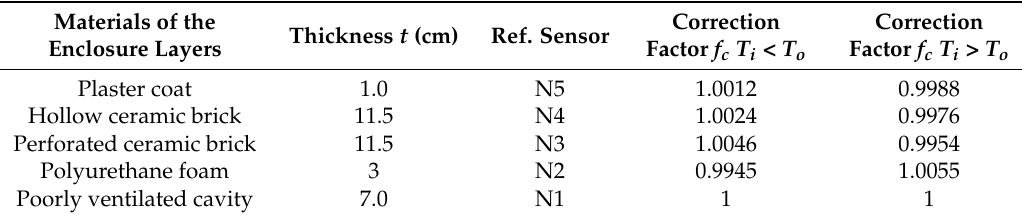
Figure 18. Picture showing the size of the complete wall and cavity made in each of the layers interpreted as a circle for simplification. Table 8. Results of U-value across different scenarios.